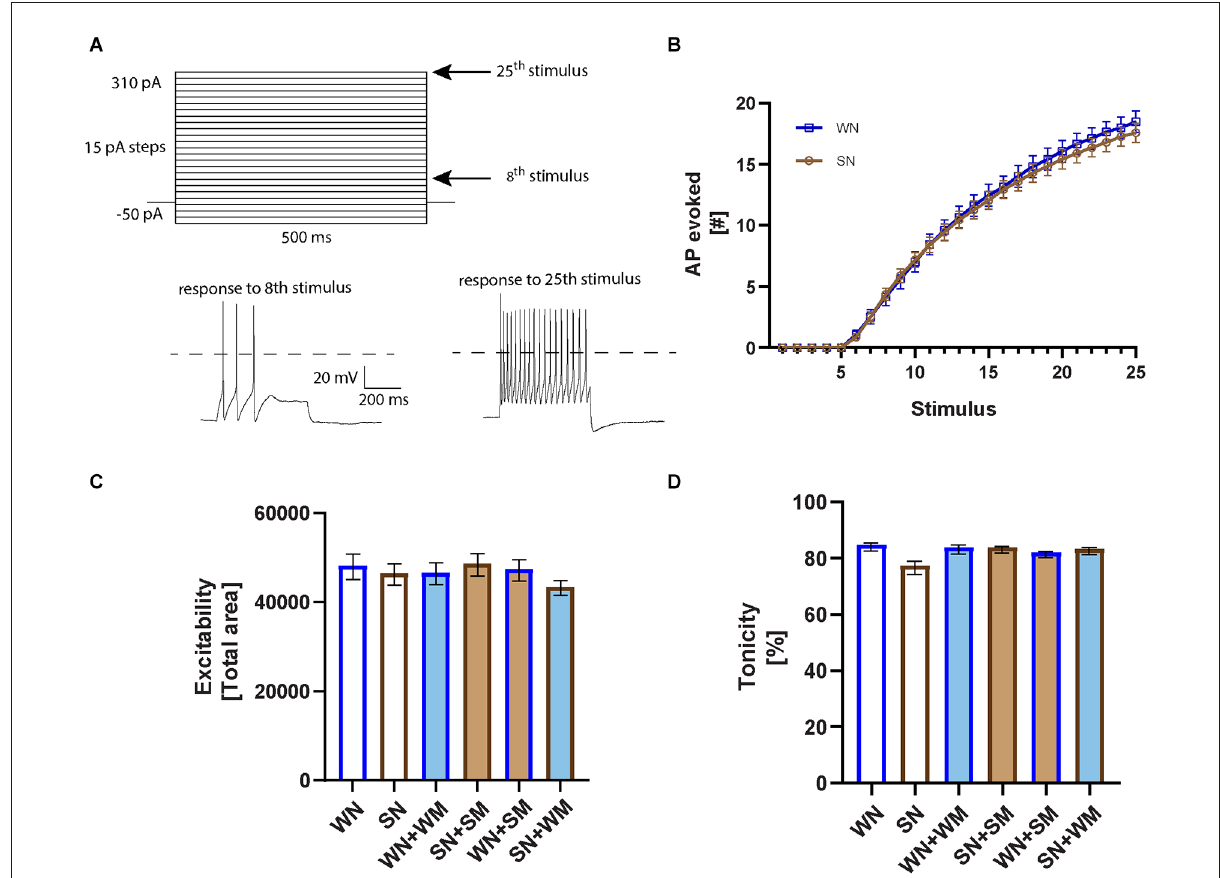
FIGURE4 Intrinsic neuronal excitability is not different in WKY and SHR neurons. (A) Square pulse stimuli pattern applied in current-clamp to evoke action potential firing. Representative recordings corresponding to the right arrows marking the 8th (55 pA) and 25th stimulus (310 pA) are plotted below. A dotted line is plotted at 0 mV. (B) Excitability curves for WKY neurons (WN) and SHR neurons (SN) cultured 2–9 DIV showing the number of evoked action potentials (APs) in response to each of the 25 stimuli; n = 26, WN; 37, SN, 2-way ANOVA with repeated measures indicates no significant difference between WKY and SHR neurons. (C) The total area under the excitability curves was calculated and averaged for each co-cultured condition (WN, n = 26 neurons from N = 10 primary culture preparations; SN, n = 37, N = 15; WN + WM, n = 28, N = 11; SN + SM, n = 30, N = 12; WN + SM, n = 28, N = 9; SN + WM, n = 34, N = 11; one-way ANOVA, error bars represent s.e.m.). (D) Tonic properties of WKY and SHR neurons. Comparison of the number of evoked APs in the first vs. the second half of the 25th stimulus for the neurons recorded from